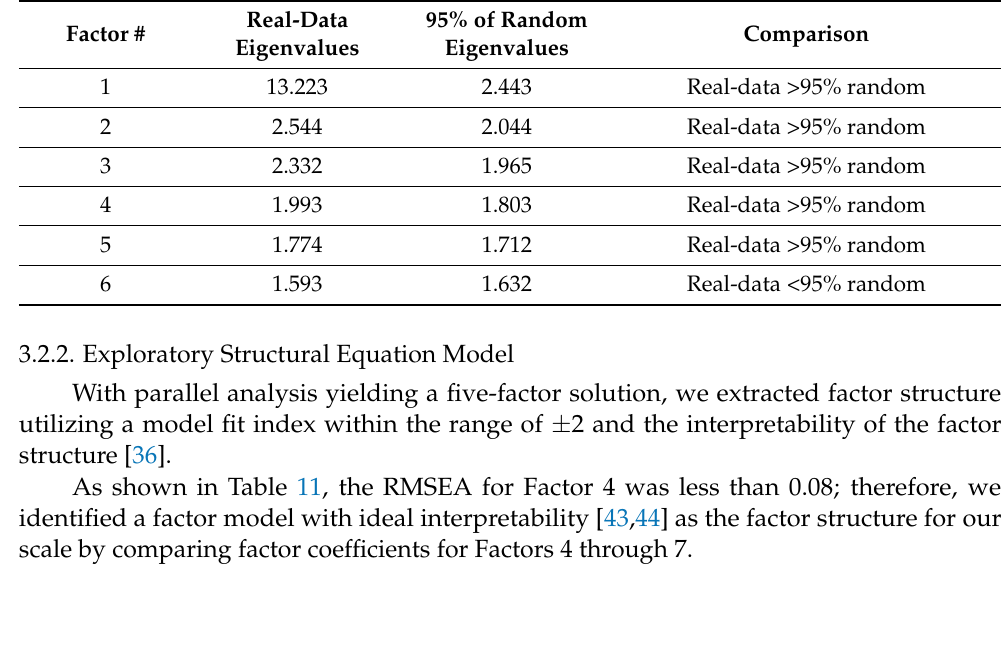
Table 10. Parallel Analysis